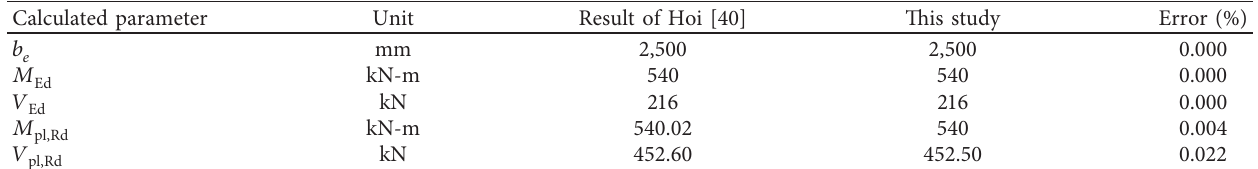
Table 4: Comparison of the results obtained in this study and in Hoi [40].